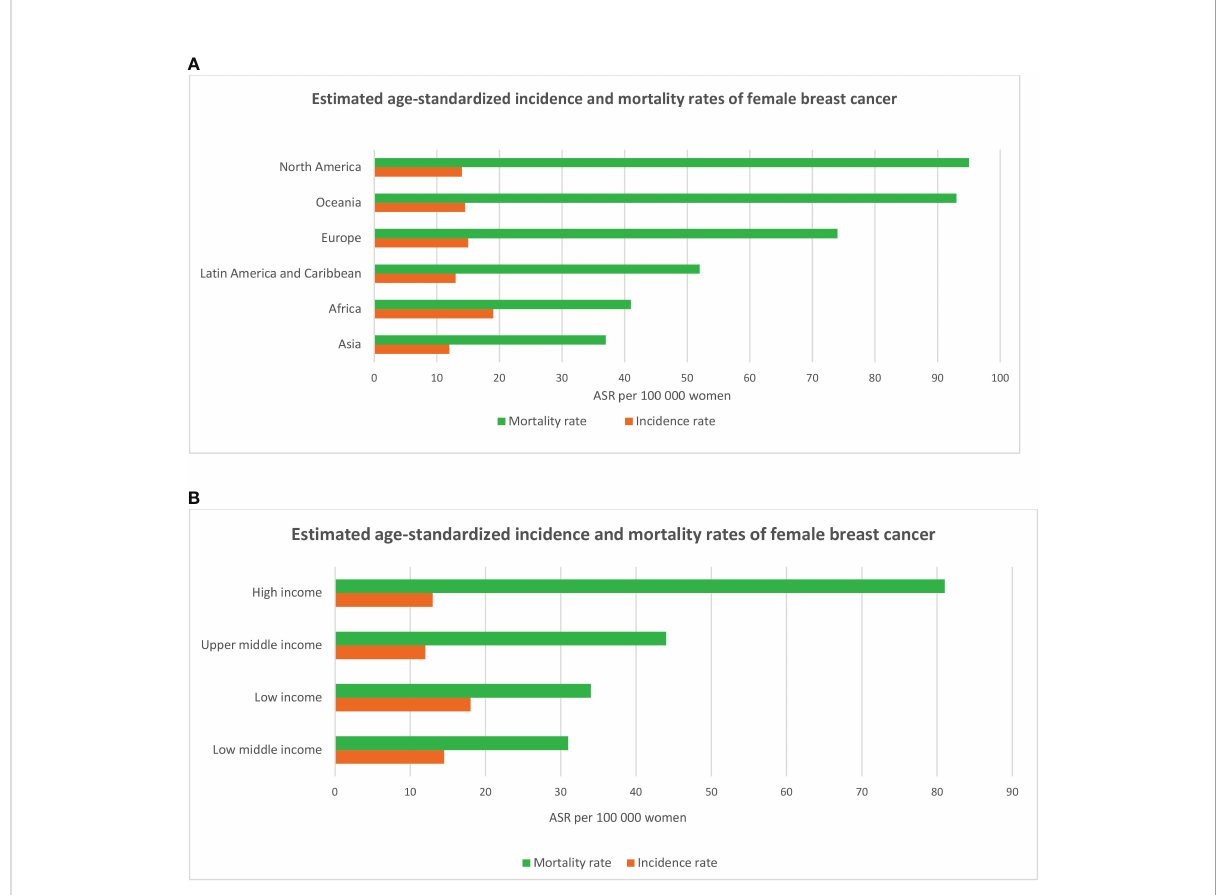
FIGURE 1 Estimated breast cancer age-standardized incidence and mortality rates across six continents (A) and in regions with different levels of income (B) according to the statistics of the International Agency for Research on Cancer (IARC - WHO) in